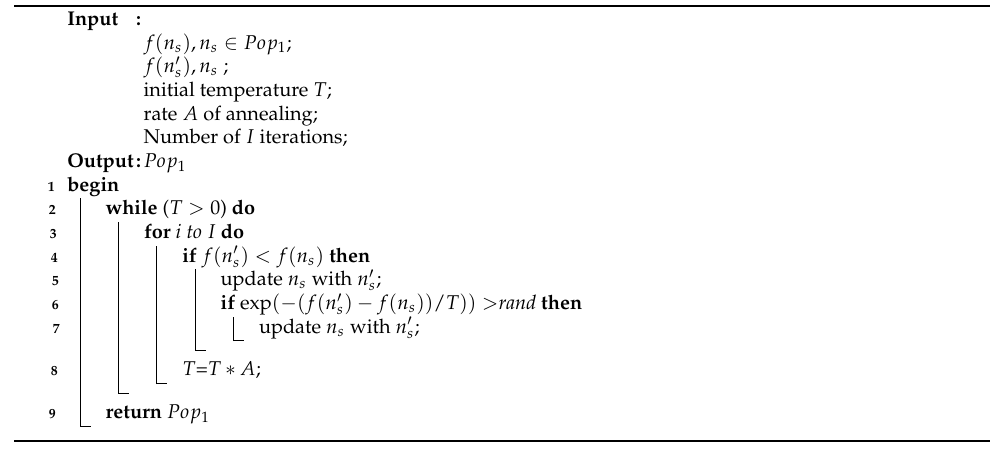
Algorithm 3: Improved Simulated Annealing